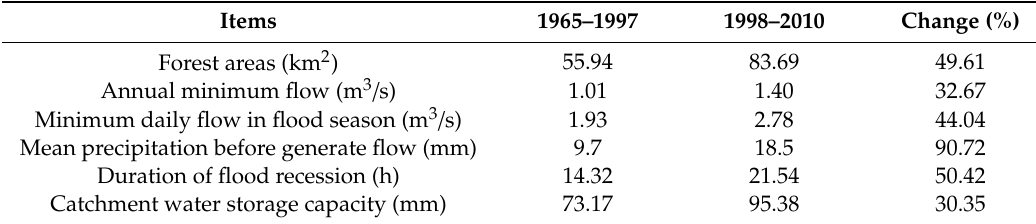
Table 9. Statistics on the convergence characteristics of Gushanchuan